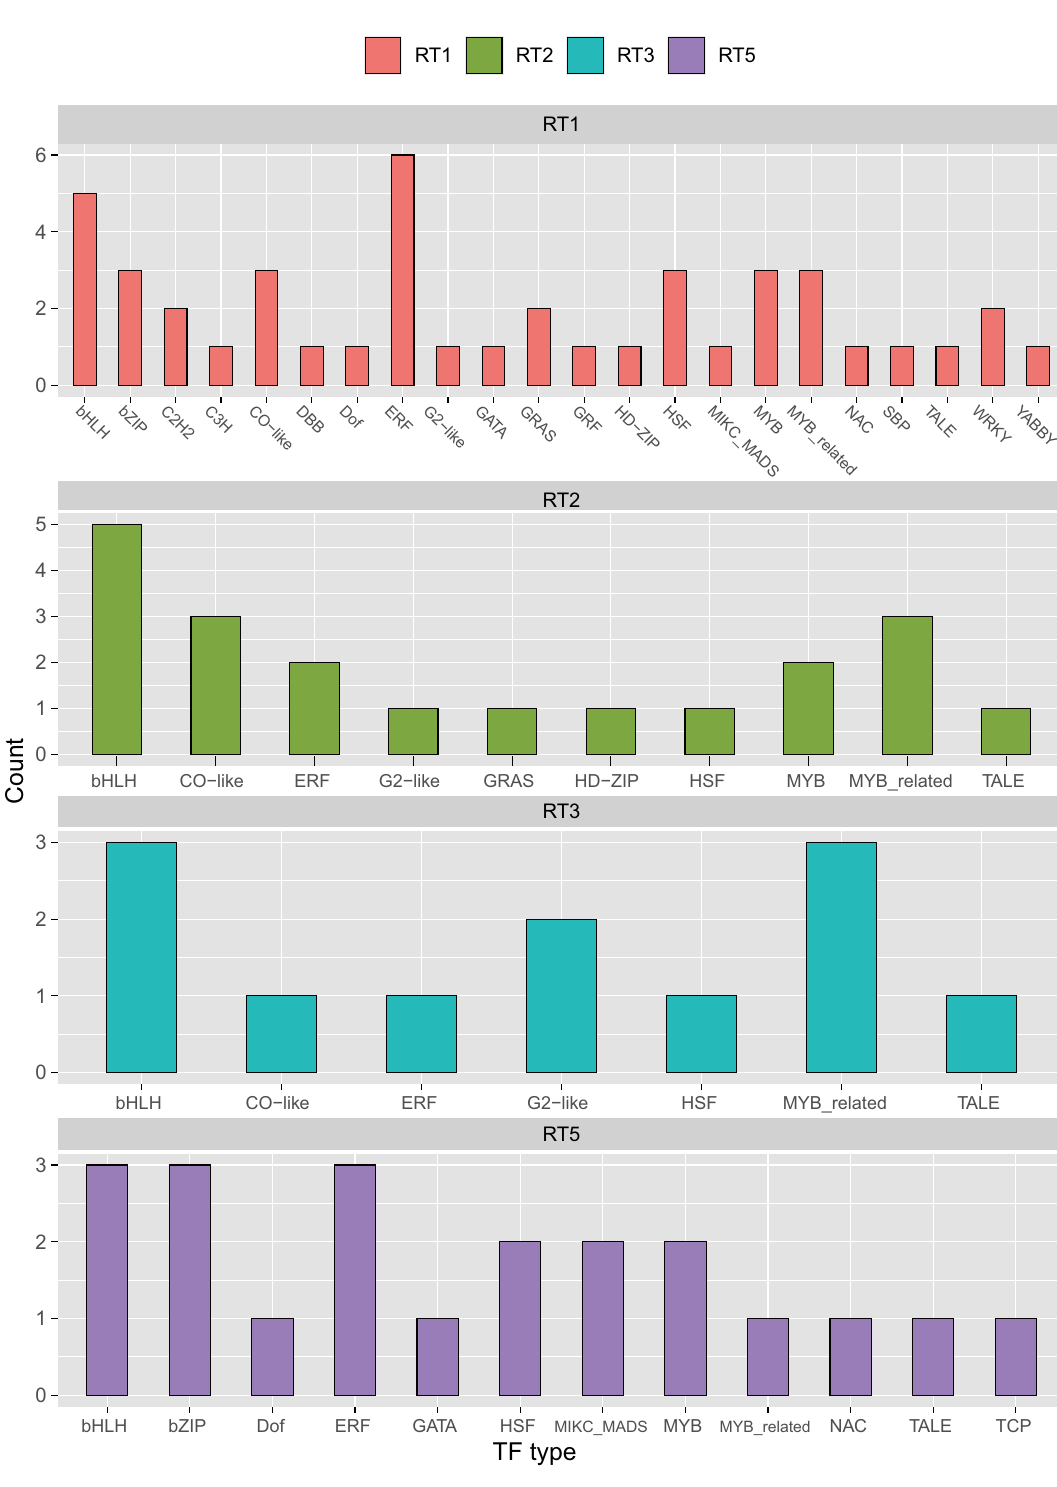
Figure 5. The distribution of transcription factor (TF) associated with disease resistance (TG-1). RT1 represents the transcription factor differentially expressed in the disease-resistant material (TG-1) on the first day after inoculation compared with that before